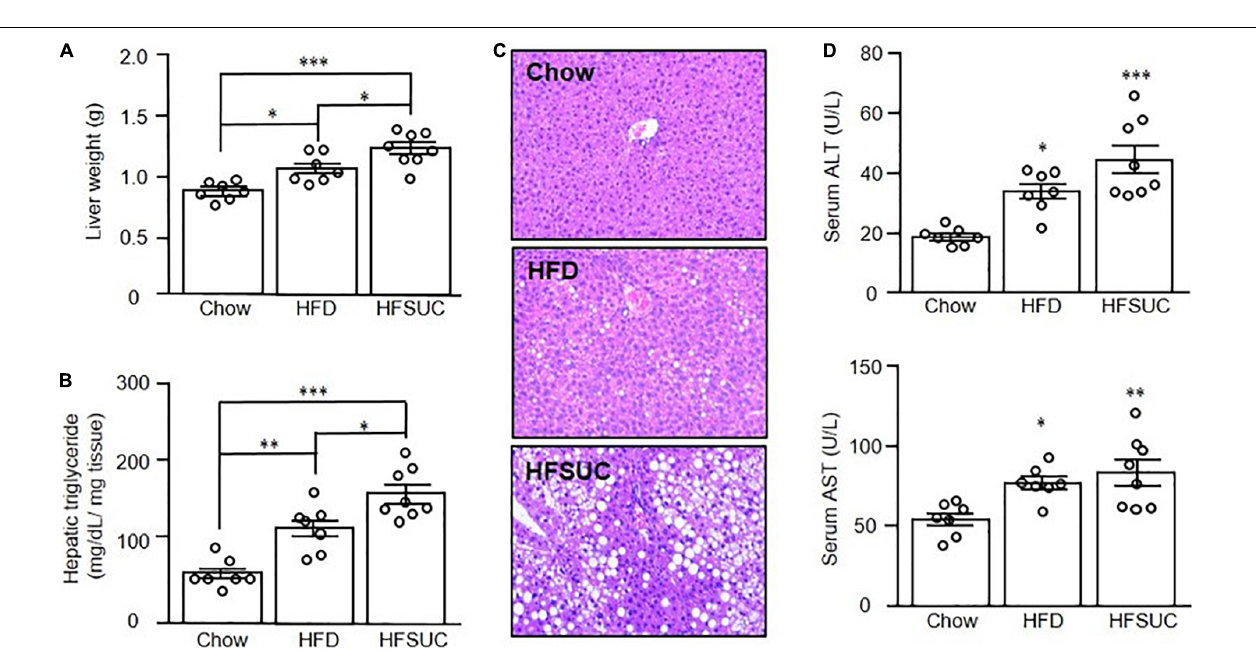
FIGURE 2 | Supplement of sucralose exacerbated high fat diet-induced hepatic steatosis in mice. Eight-week-old C57BL/6 mice were fed with a chow diet (Chow), high-fat diet (HFD), or HFD supplemented with sucralose (HFSUC) for 12 weeks. At the end of the experiments, each group of the mice was sacrificed and the liver tissues were removed and weighed (A) . Hepatic triglyceride contents for each group of the mice were measured using a commercialized assay kit (B) . In addition, the liver sections were stained with hematoxylin and eosin (100X) (C) . Serum samples were collected for the determination of alanine aminotransferase (ALT), and aspartate aminotransferase (AST) levels (D) . Data are mean ± SEM ( n = 7–8 for each group of the mice) ∗ p < 0.05, ∗∗ p < 0.01, ∗∗∗ p < 0.001 as compared with the Chow group or indicated groups.